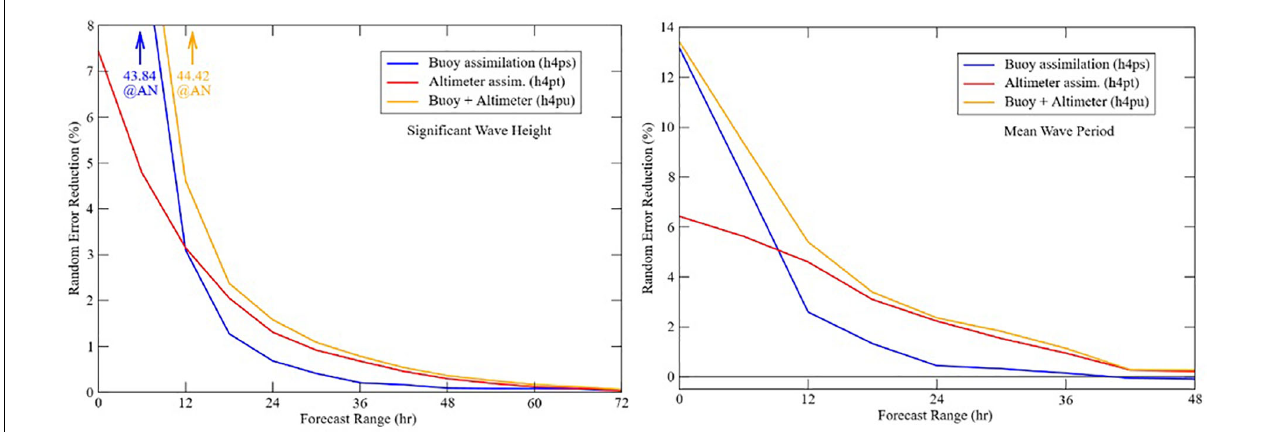
FIGURE 11 | Random error reduction in significant wave height H S (left) and mean wave period (right) from all performed experiments compared to the experiment without data assimilation, verified with all available in-situ data for the whole month of October 2018. Note that the random error reduction by in-situ-assimilation and the combined in-situ-altimeter assimilation shoot up at analysis times to the depicted